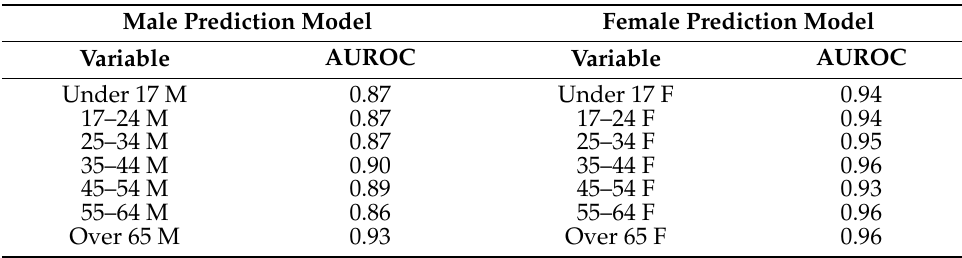
Table 4. The AUROC values for each output variable of each model.